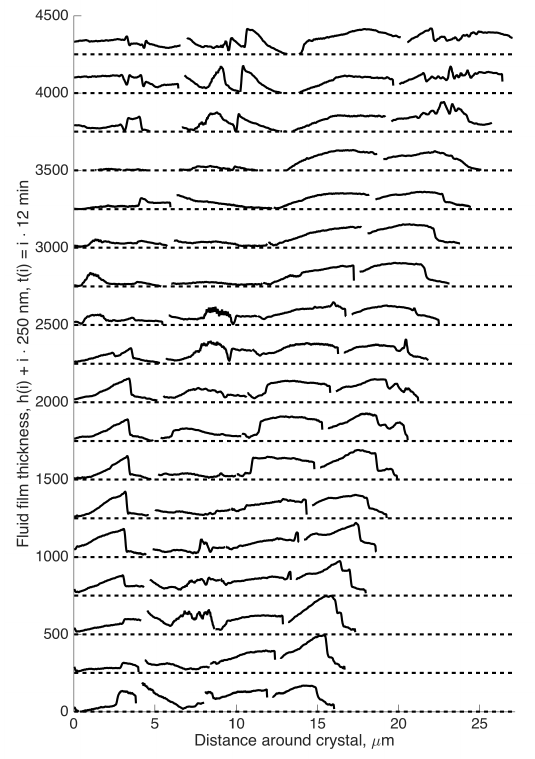
Figure 5. Profiles of the crystal: glass distance (fluid film thickness), h , around the rim of Crystal B at different times. Each new profile is shifted 250 nm up to separate them.